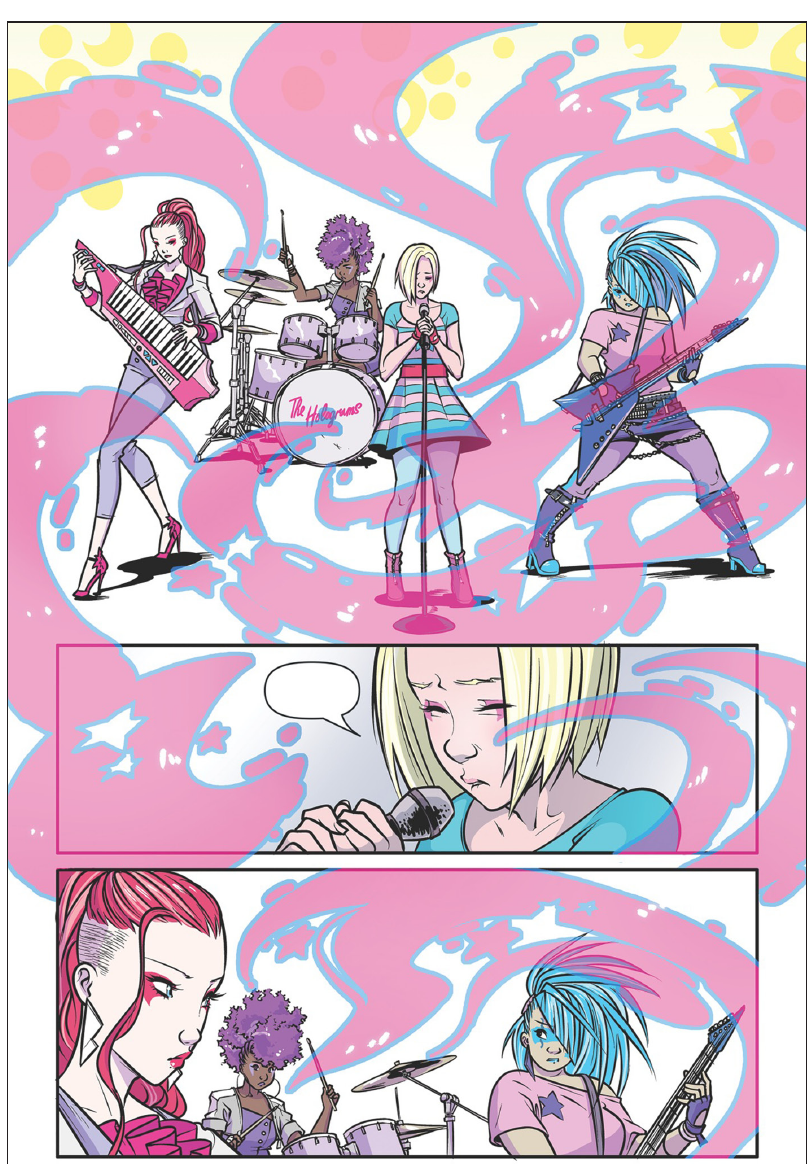
Figure 2: Jerrica tries to sing Showtime (Thompson and Campbell, 2015. © Hasbro